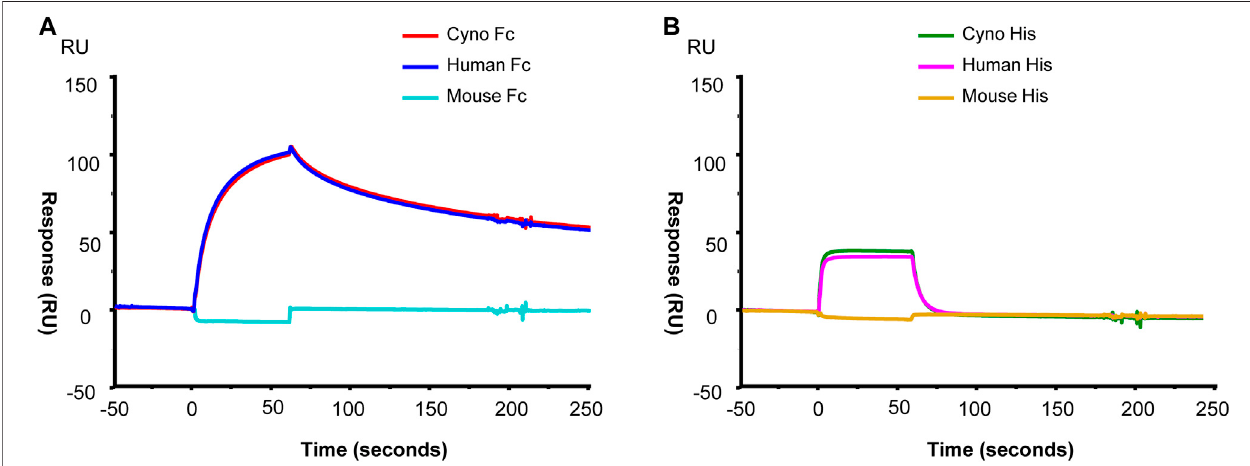
FIGURE2| SPRanalysisoftheRPH-120bindingtohuman,cynomolgusormousePD-L1.RPH-120wasimmobilizedonaCM5sensorchipthenhuman,monkey or mouse Fc-tagged PD-L1 (Panel A ) or His-tagged PD-L1 (Panel B ) proteins were applied at 30 µl/min for 1 min to generate the sensograms.